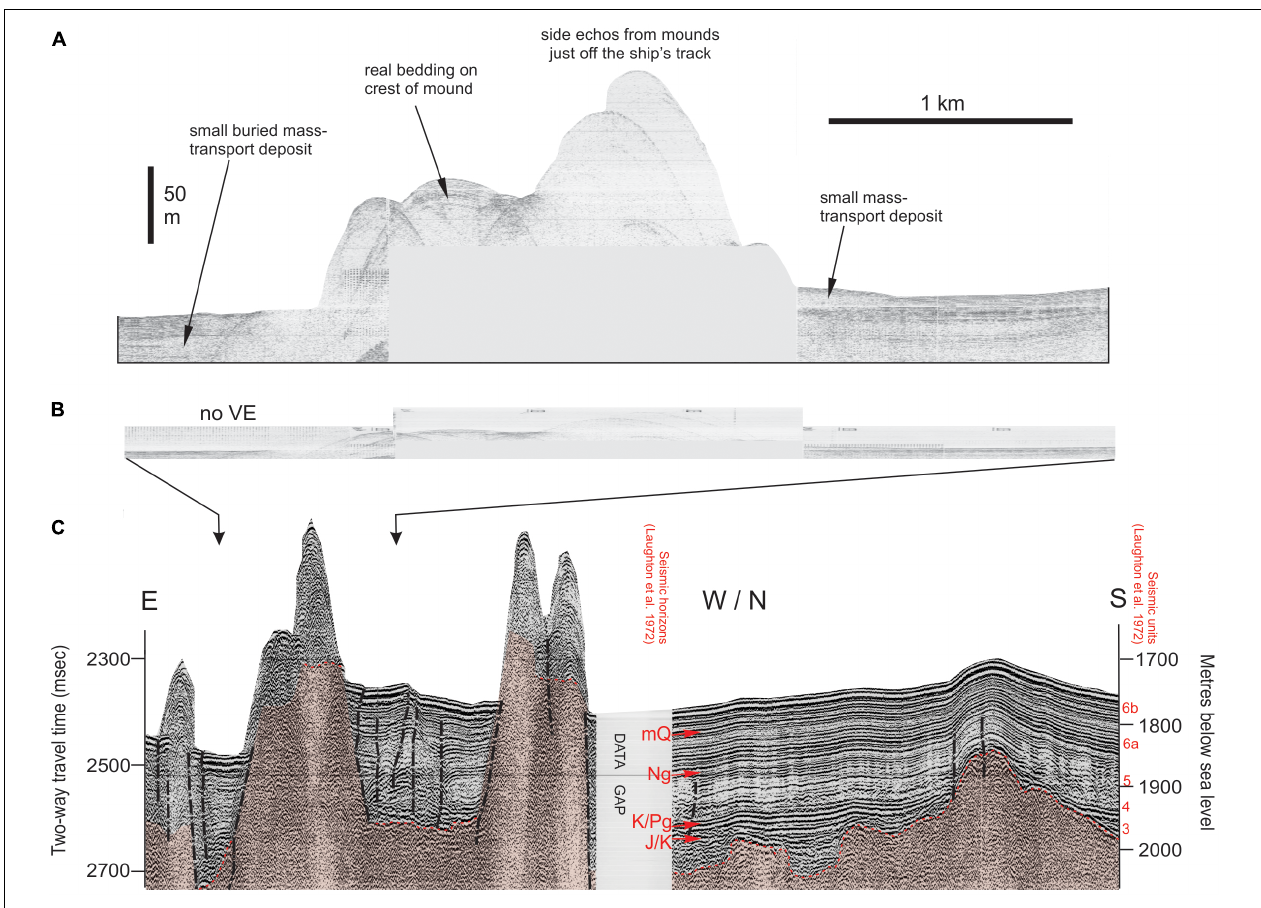
FIGURE 4 | Seismic profiles across mounds on northeast Orphan Knoll ( A , top panel). Huntec sparker profile across a cluster of mounds showing > 10 m stratified sediment on one mound crest and small mass-transport deposits on the mound flanks (B, middle panel). The above profile shown with no vertical exaggeration ( C , lower panel). 40 cu in GI gun seismic profile showing several mounds, with faulting in stratified section between the mounds. S end of the profile is 5 km north of DSDP Site 111. 3, 4, 5, 6a, 6b are seismic units from Laughton et al. (1972). mQ, mid Quaternary marker (?ca. 1Ma); Ng, thin Neogene (Miocene) unit; K/Pg, Cretaceous-Paleogene boundary; J/K, Jurassic-Cretaceous unconformity. All images from CCGS Hudson cruise 2004-024. See Figure 5B and Supplementary Figure 4 for location of seismic profiles